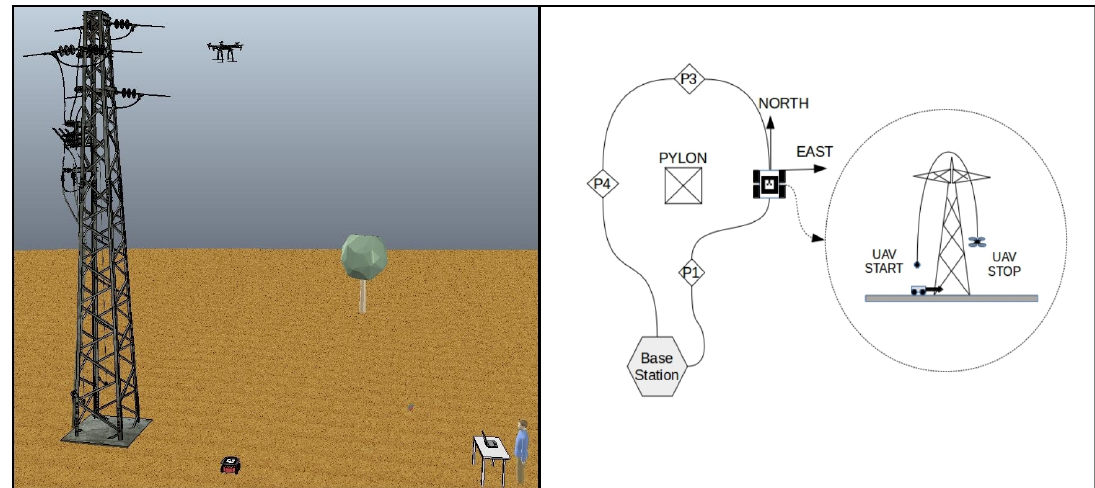
Figure 1. Overview of the